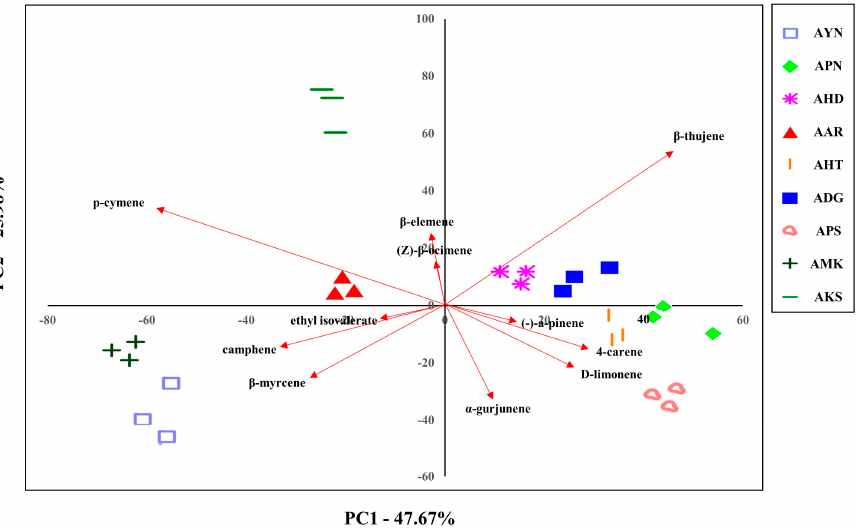
Figure 6. Plot showing the PCA based on the floral volatile compounds of nine Aster species’ flowers using